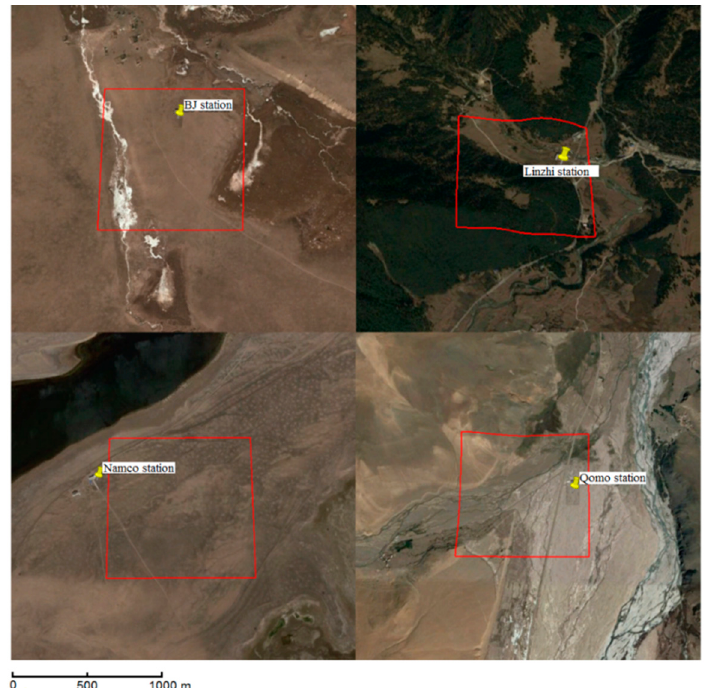
Figure 11. The four ground stations location on the Tibetan Plateau (yellow pin) and the footprint of the pixel used for the validation (red lines). BJ (31°22’N, 91°53’E), Linzhi (29°45’N, 94°44’E), NamCo (30°46’N, 90°59’E), Qomo (28°21’N, 86°56’E).